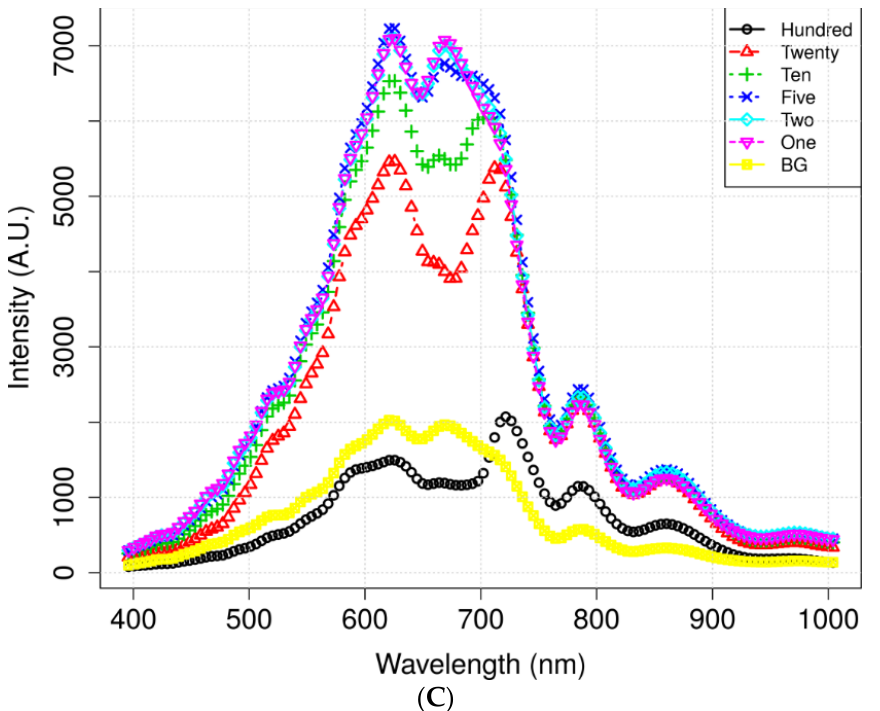
Figure 4. Mean spectrum data of ( A ) potato and its locational ( B ) residues according to the dilutions and background (BG) pixels. ( C ) Mean spectra of spinach.